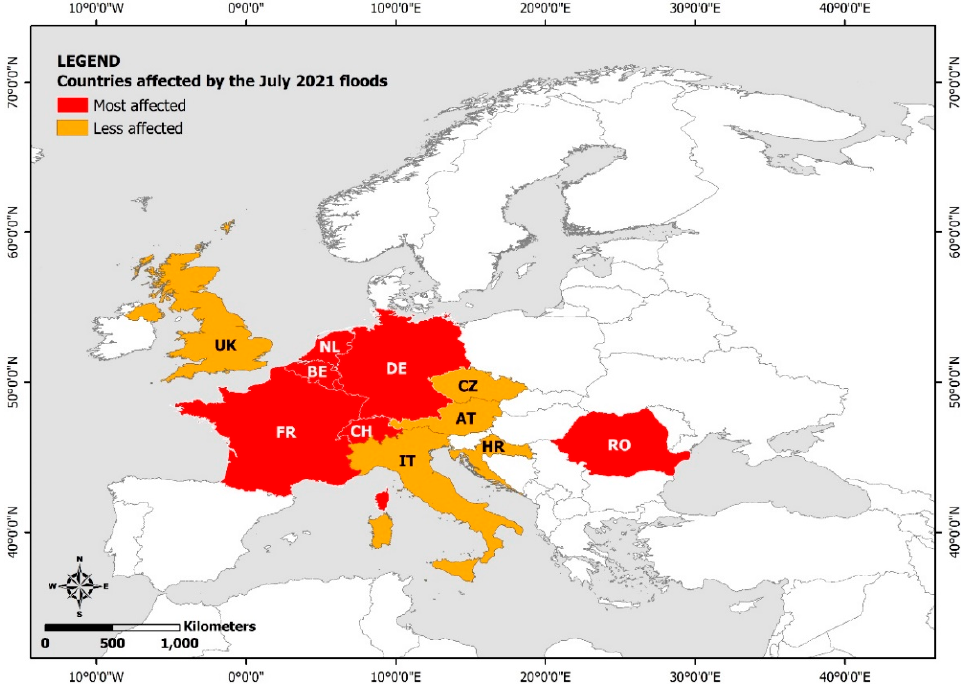
Figure 1. European countries affected by the July 2021 floods.